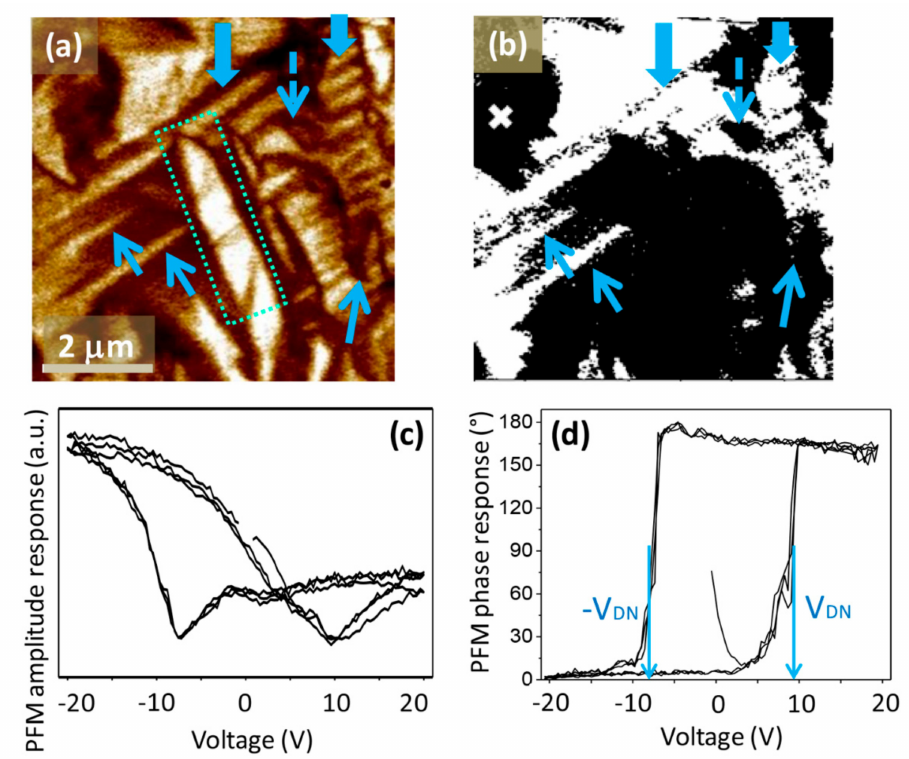
Figure 2. Piezoresponse force microscopy (PFM) out-of-plane ( a ) amplitude and ( b ) phase images (drive AC signal: 3 V, 350 kHz). The examples of wedge domains (thin solid arrows), lamellar-like domains (thick solid arrows), and irregularly shaped domains (dashed arrow) are shown. Local hysteresis loops; ( c ) amplitude, and ( d ) phase measured after scanning the PFM images in the spot marked by a cross in ( b ). The ± V DN is marked by vertical arrows in the panel ( d ).